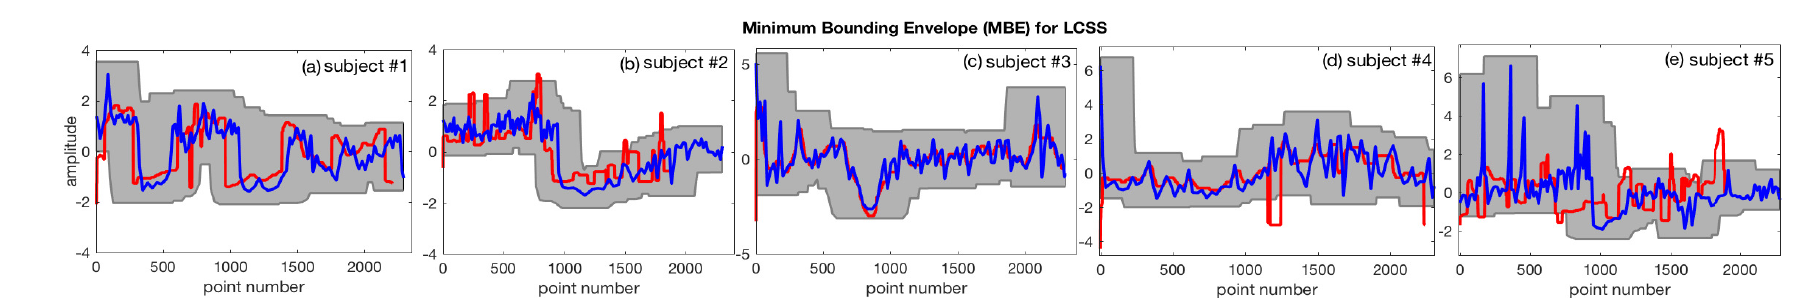
Figure 10. Estimated instantaneous respiratory rate for five subjects wearing the Wavelethealth sensor (red curve) versus reference respiratory rate obtained using thermocouple (blue curve): ( a ) subject #1; ( b ) subject #2; ( c ) subject #3; ( d ) subject #4; ( e ) subject #5.